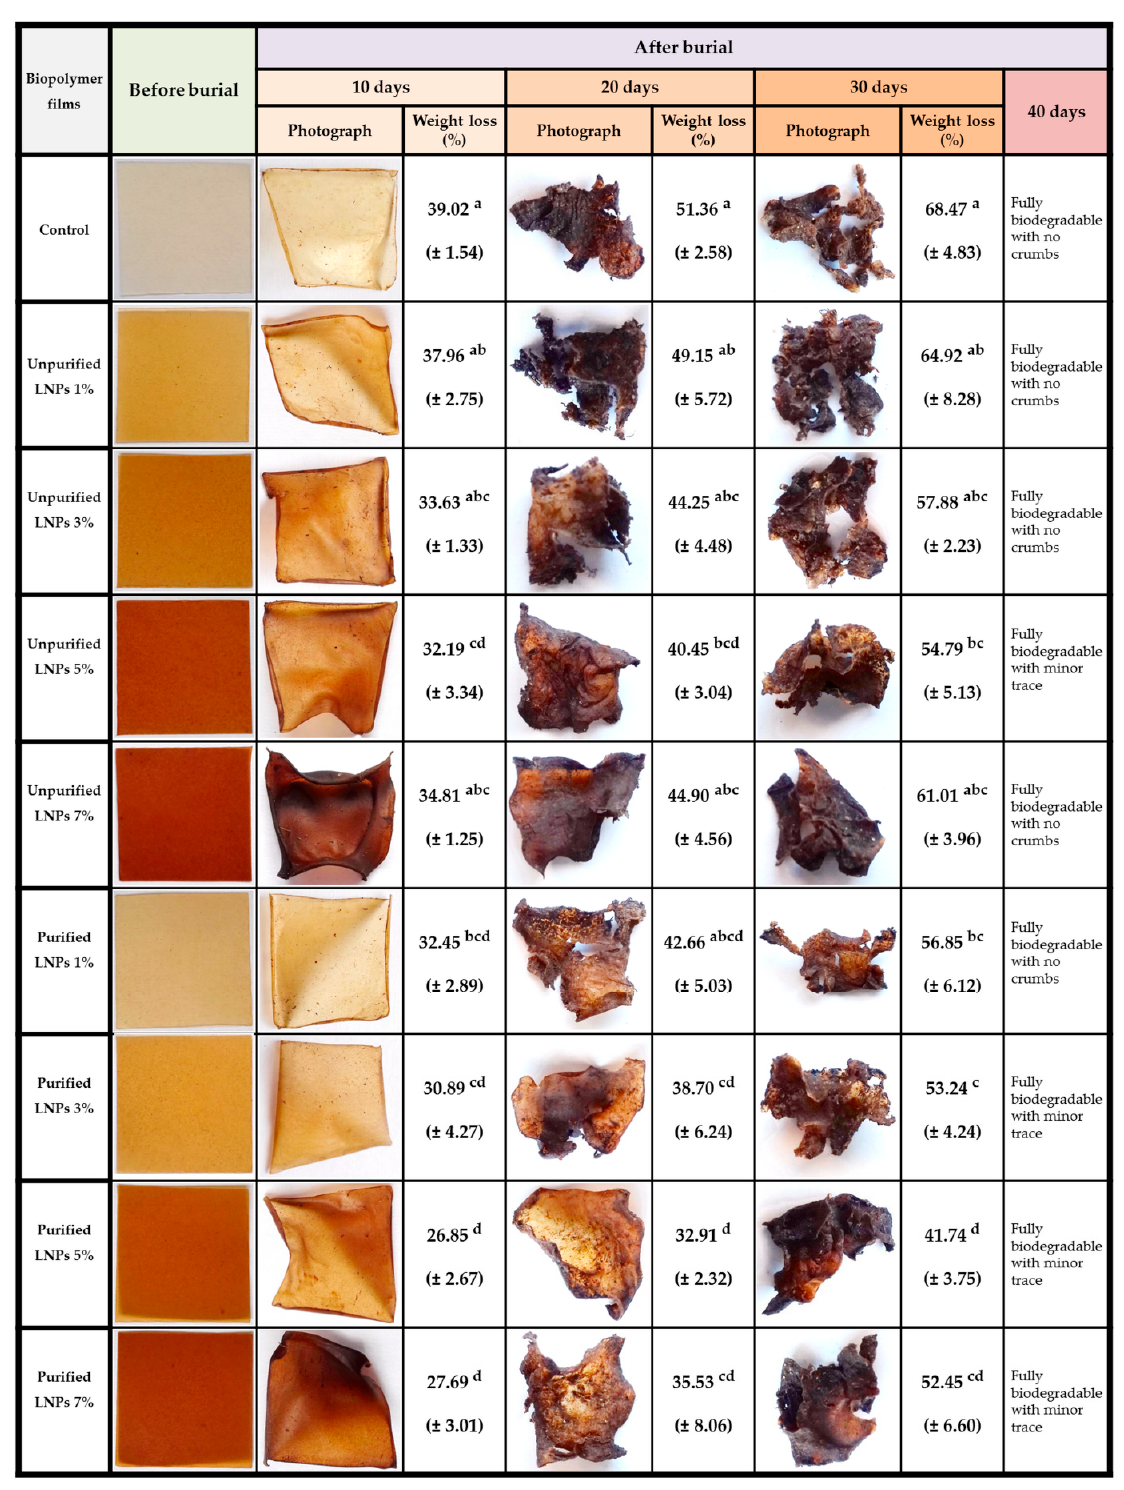
Figure 8. Digital images and weight loss before and after soil burial of biodegradable plastic films at 0, 10, 20, 30, and 40 days. Means in the same column followed by the same superscript letters denote no significant difference ( p < 0.05).